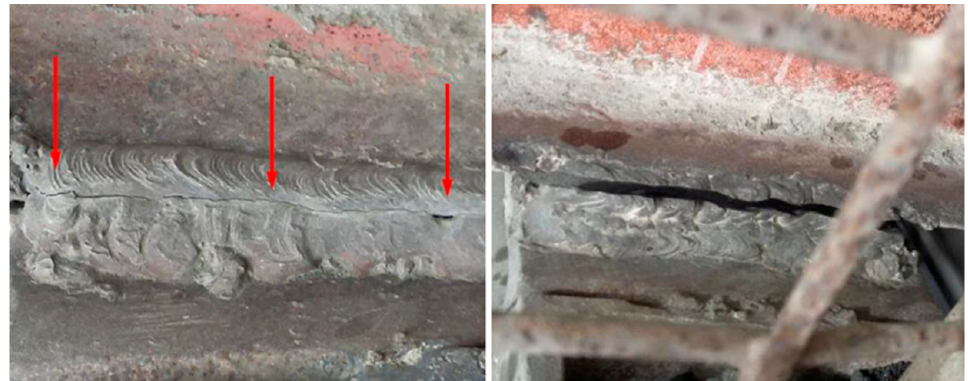
Figure 2. Fatigue cracks.